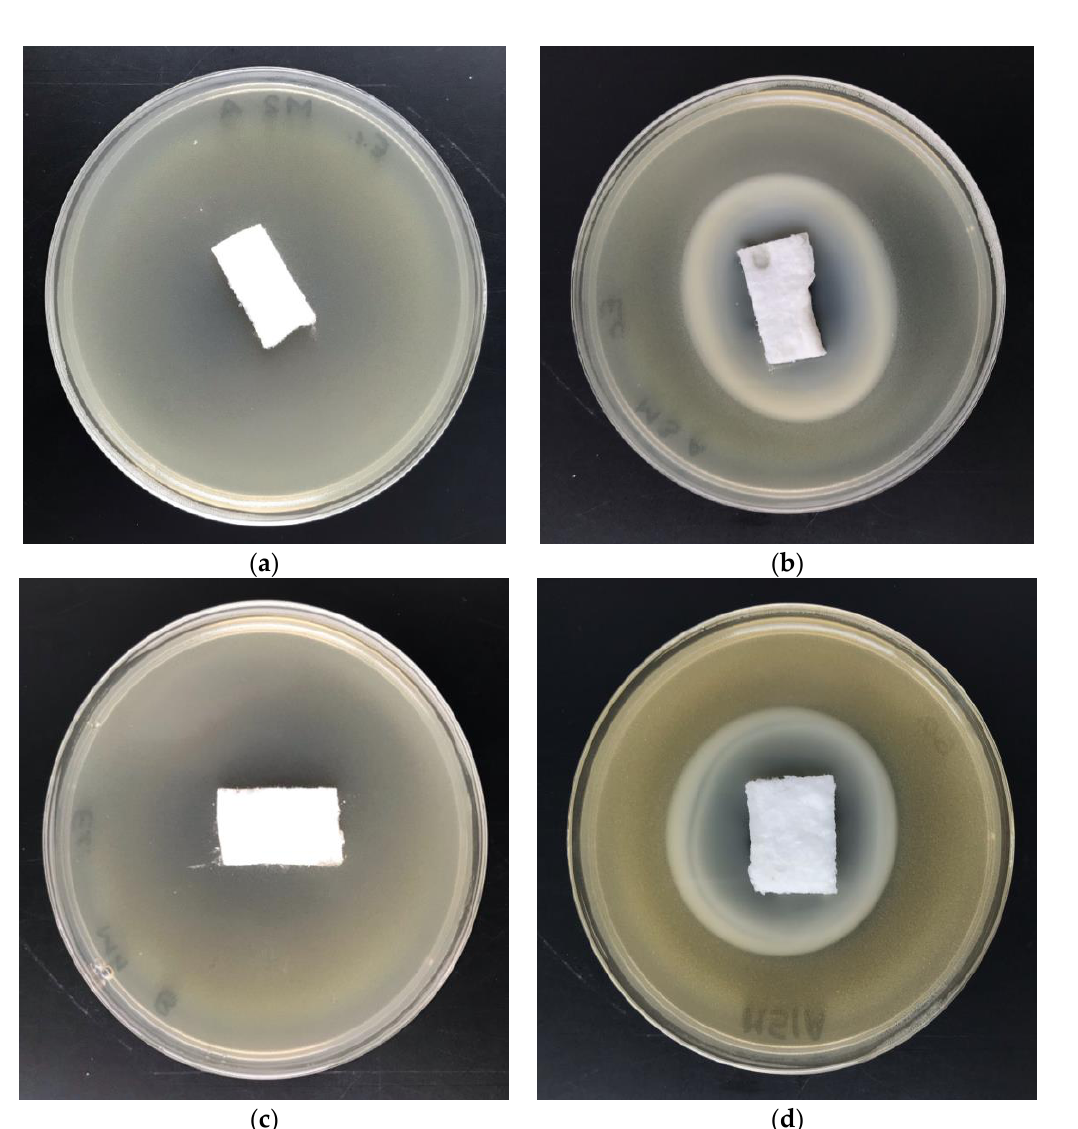
Figure 12. Zone of inhibition test results on Petri dishes showing antibacterial activity: ( a , b ) — E. coli ; ( c , d ) — S. aureus ; ( a , c ) Control: unmodified PLA nonwoven fabric, ( b , d ) Sample: PLA-ALG-Zn (2+) .